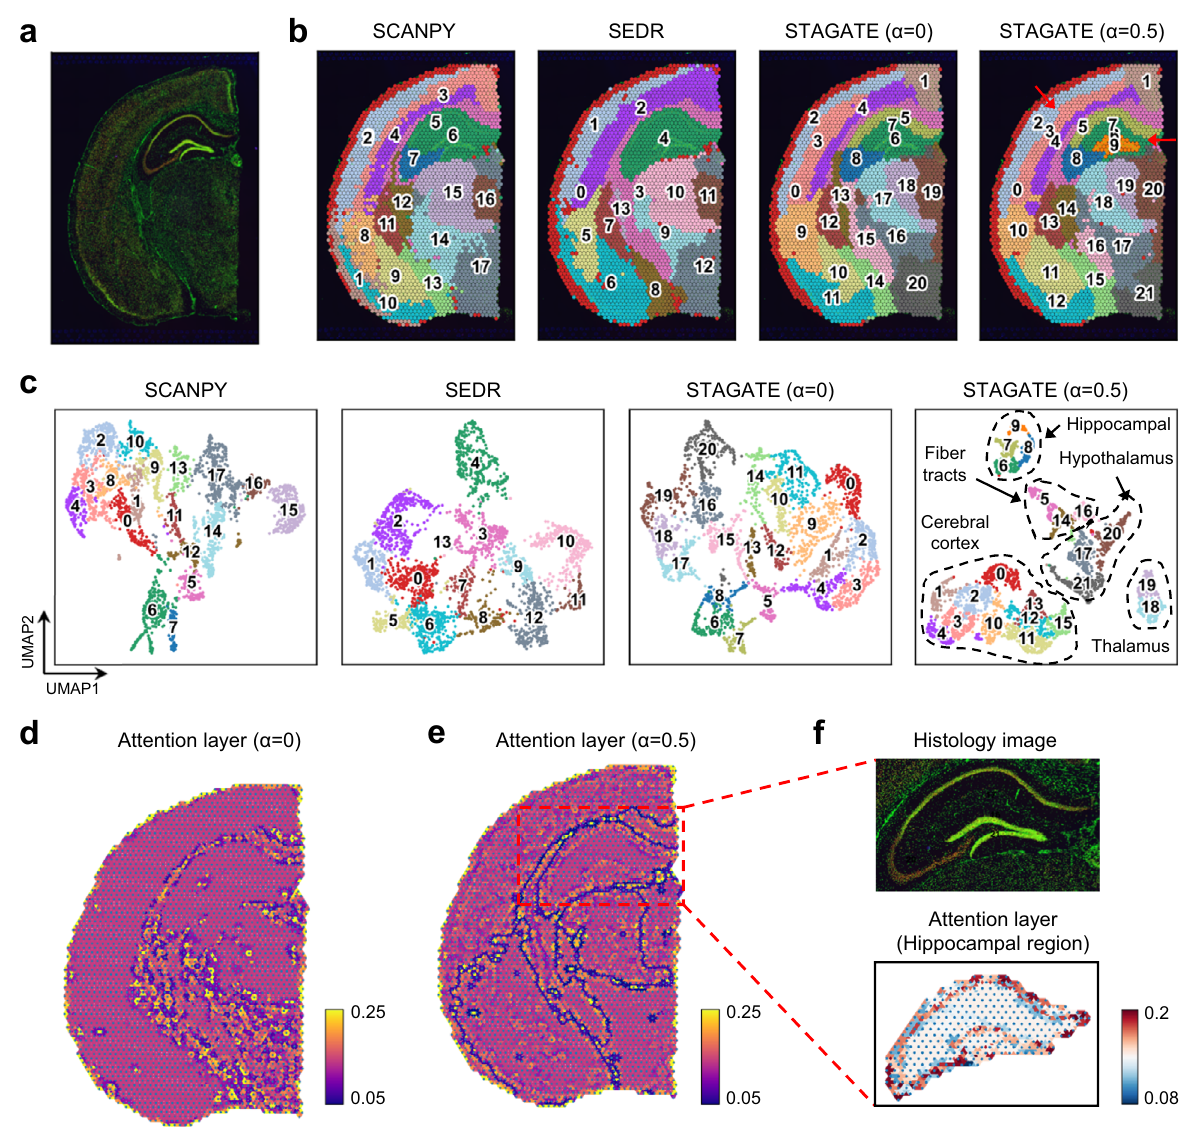
Fig. 5 STAGATE reveals spatial domains in adult mouse brain section pro fi led by 10x Visium. a Immuno fl uorescent imaging of the tissue section stained with DAPI and Anti-NeuN. b Spatial domains generated by Louvain clustering with resolution = 1 on the low-dimensional embeddings of SCANPY, SEDR, STAGATE, and STAGATE with the cell type-aware module. The α represents the weight of the cell type-aware SNN (see Fig. 1). c UMAP visualizations of the low-dimensional embeddings of SCANPY, SEDR, STAGATE, and STAGATE with the cell type-aware module respectively. d , e Visualizations of the attention layer of STAGATE without ( d ) or with ( e ) the cell type-aware module. The nodes of the attention layer are arranged according to the spatial position of spots. The edges of the attention layer are colored by corresponding weights. f Zoomed-in views of immuno fl uorescent imaging of the hippocampus region and the visualization of attention layer in e